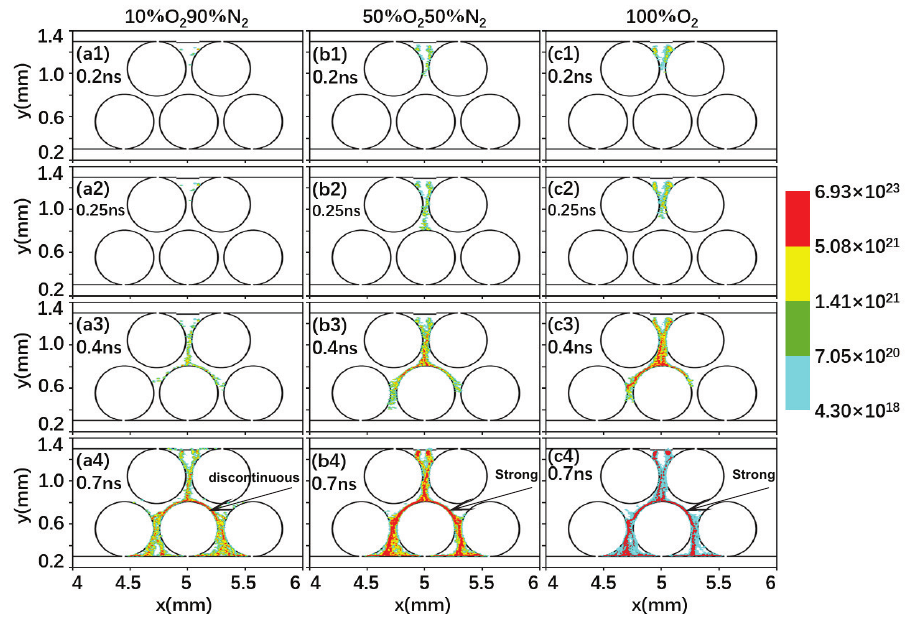
Figure 10. O + ion density (m − 3 ) for the same conditions as in Figure 8. 2